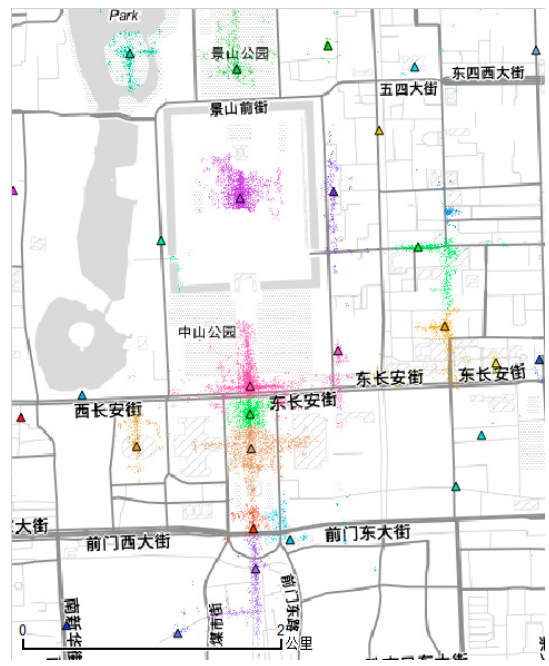
Figure 6. Cluster distribution map in Tiananmen Square and its surrounding area.